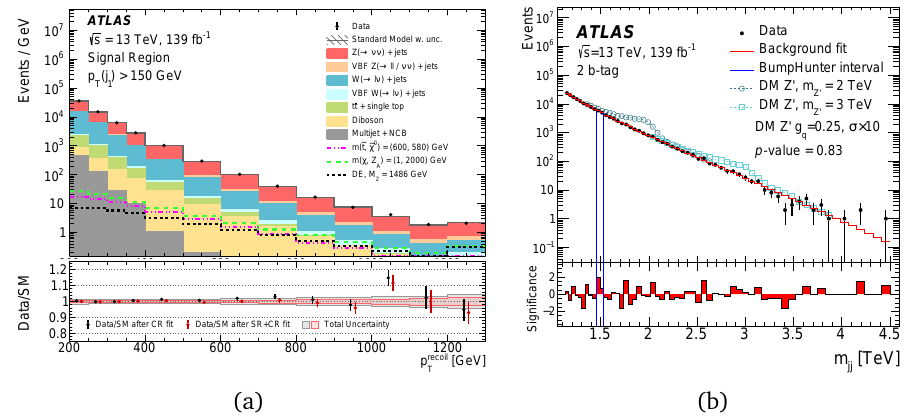
Figure 1: (a) E miss distribution compared with SM predictions (see text). Benchmark T signals distributions are represented with dashed lines. Figure from [ 3 ] . (b) Invariant mass distribution of two jets (see text). Figure from [ 5 ]